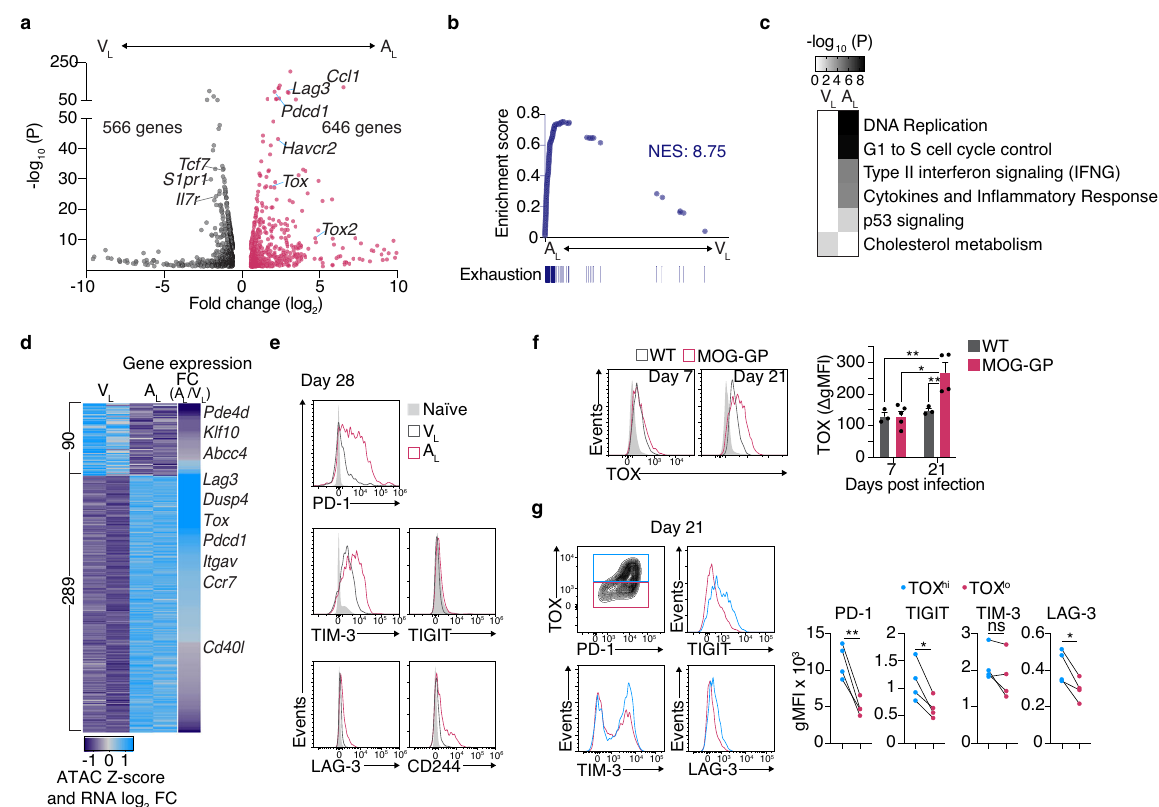
Fig. 2 Self-reactive CD8 + T cells express a gene program of T-cell exhaustion. 10 4 naive P14 cells were adoptively transferred into WT and MOG-GP mice. One day later (day 0), mice were challenged i.c. with 10 4 PFU rLCMV-GP33. Brain in fi ltrating P14 cells were FACS sorted for RNA-seq ( a – d ) and ATAC-seq ( d ) 21 days later or isolated for fl ow cytometric analysis at indicated days post infection ( e – g ). a Volcano plot of differentially expressed genes (DEGs) (FC ≥ 1.5; FDR < 0.05) in A L vs. V L ( n = 3 mice/group). b Gene set enrichment analysis (GSEA) of a signature of exhaustion (chronic LCMV